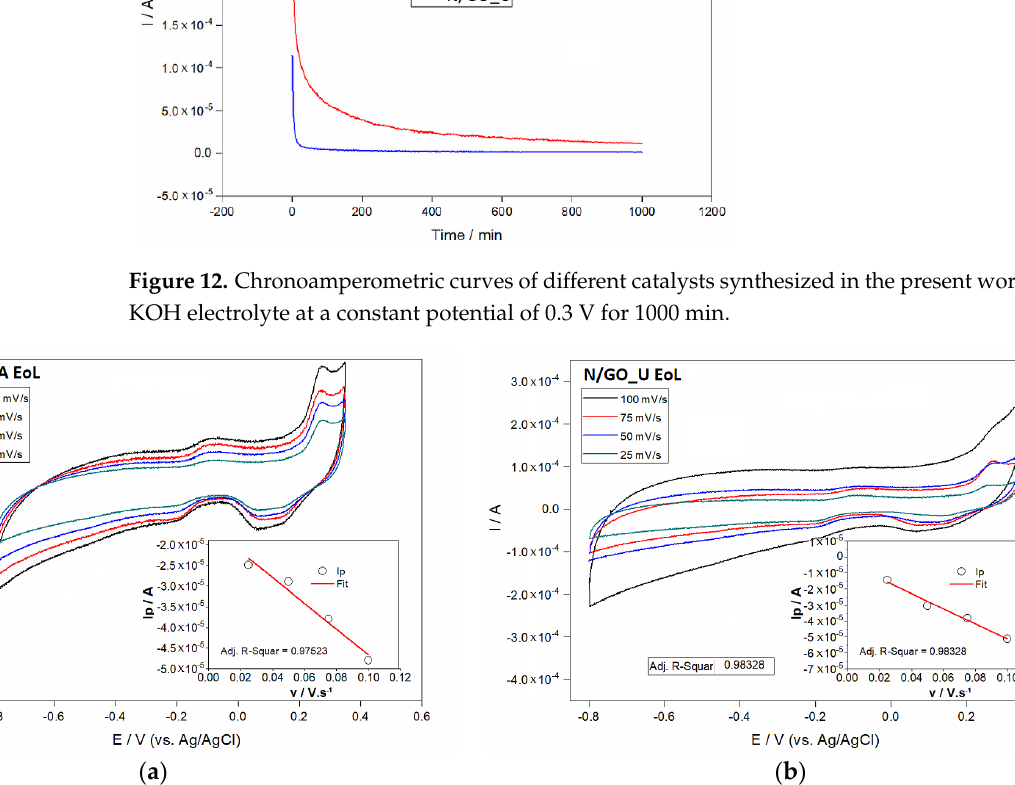
Figure 13. Cyclic voltamograms at different scan rates for N/GO_A ( a ) and N/GO_U ( b ) for EoL. Right bottom insert plot of the dependency of the oxidation peak current on the square root of rate.